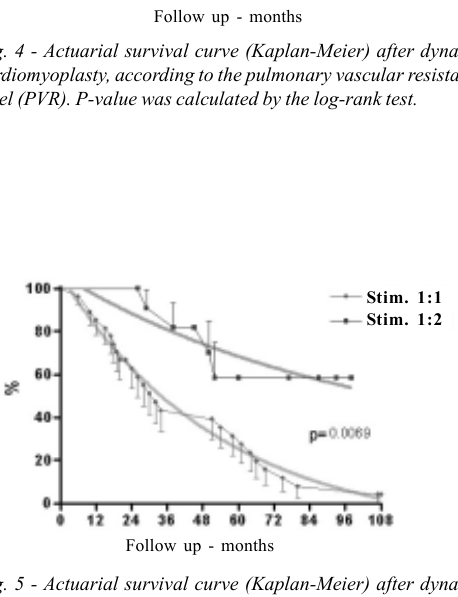
Table 4. Correlation of the pre-, intra- and post-operative factors with morbid events by sudden death or arrhythmia